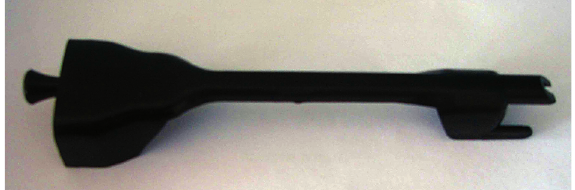
Figure1 – Disposable Needle Guide (Matek; Geotek, Inc., An- kara, Turkey) disposable needle guide.